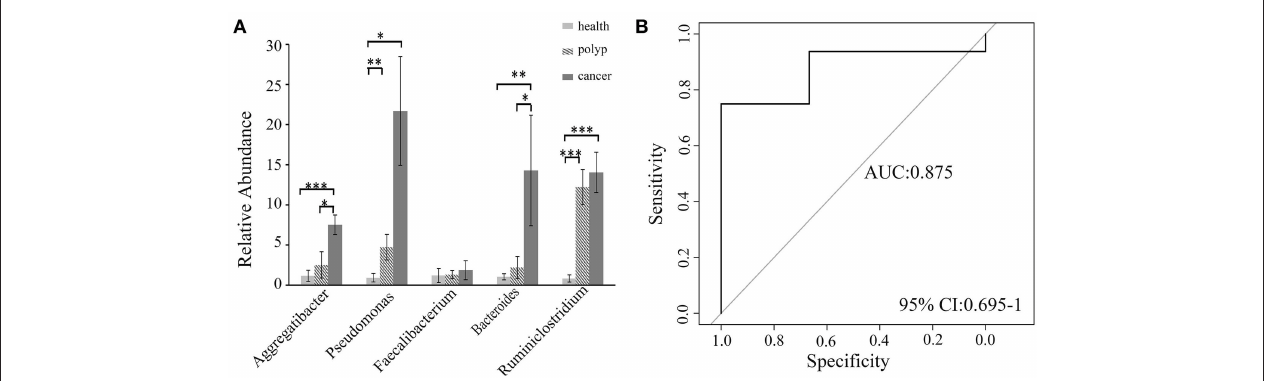
FIGURE 5 | Validation of the potential throat markers for throat cancer diagnosis. (A) Quantitative polymerase chain reaction (qPCR) quantification analysis of Pseudomonas , Aggregatibacter , Bacteroides , Faecalibacterium , and Ruminiclostridium in the throat cancer group, vocal cord polyp group, and healthy control group; * P < 0.05, ** P < 0.01, *** P < 0.001. (B) Receiver operating characteristic (ROC) curve analysis for throat cancer with the predictive bacterial biomarkers ( Pseudomonas, Aggregatibacter, Bacteroides , and Ruminiclostridium ). ROC curve analysis for throat cancer with the predictive bacterial